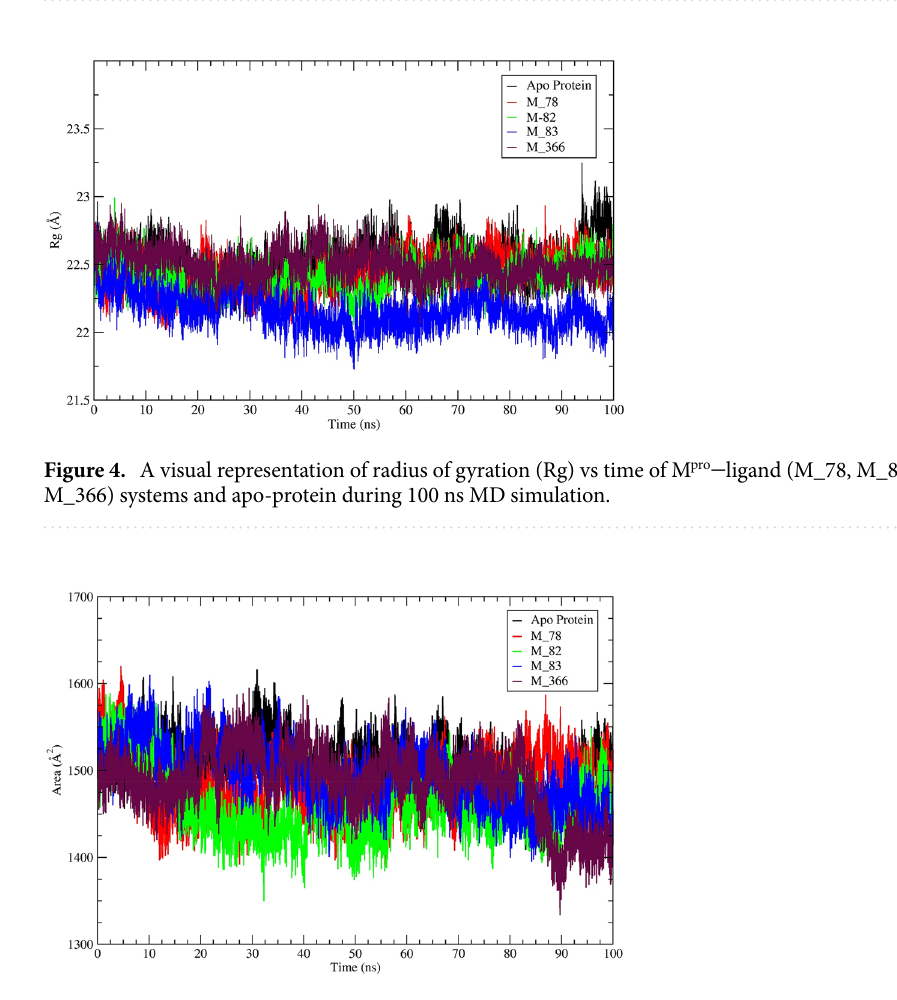
Figure 5. A visual representation of solvent accessible surface area (SASA) of M pro ‒ ligand (M_78, M_82, M_83, M_366) systems and apo-protein during 100 ns simulation